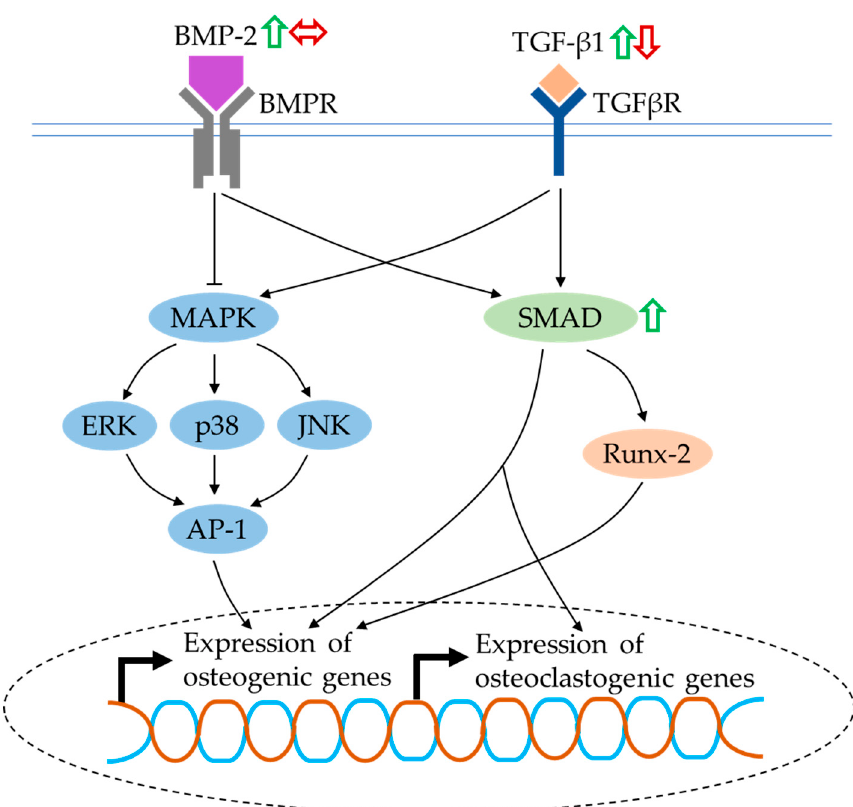
Figure 7. The effects of quercetin on the regulation of BMP and TGF- β signalling in protecting bone. The interaction of BMP-2 and TGF- β with their respective receptors results in the upregulation of osteogenic genes and osteoclastogenic genes via activation of SMAD proteins and/or inhibition of MAPK. Quercetin may cause positive (indicated by the green arrows) or negative effects (indicated by the red arrows) on the levels of BMP-2, TGF- β and SMAD protein in bone cells. Abbreviations: AP-1 = activator protein-1; BMP-2 = bone morphogenetic protein-2; BMPR = bone morphogenetic protein-2 receptor; ERK = extracellular signal-regulated kinase; JNK = c-Jun N-terminal kinase; MAPK = mitogen-activated protein kinase; Runx-2 = runt-related transcription factor 2; SMAD = Suppressor of mothers against decapentaplegic; TGF- β 1 = transforming growth factor-beta 1; TGF β R = transforming growth factor-beta receptor